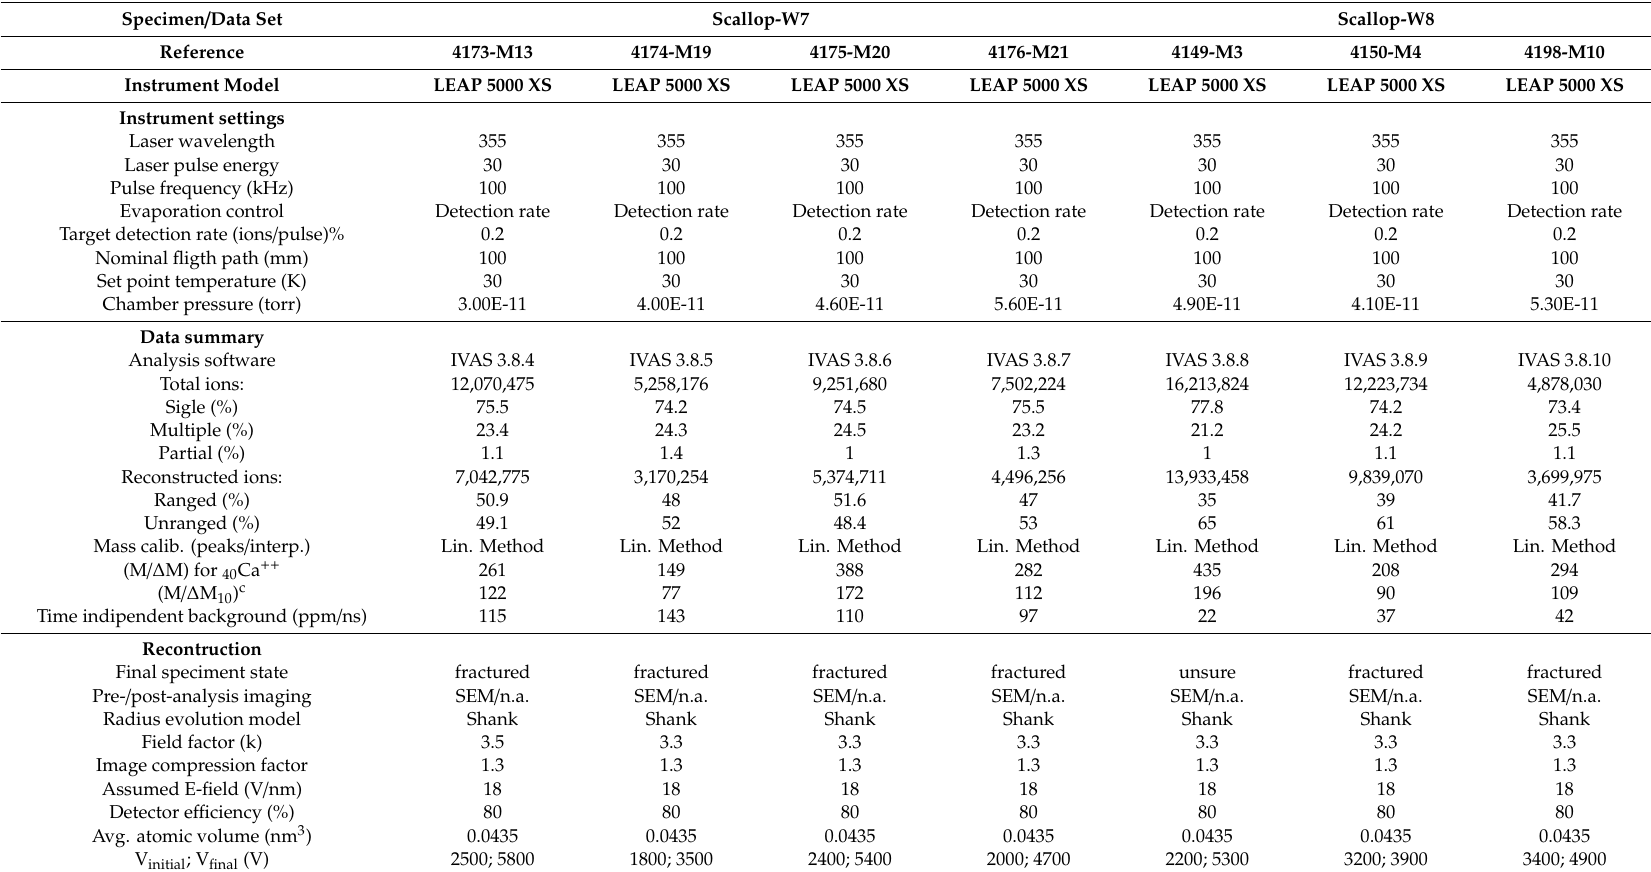
Table 1. Data acquisition settings for LEAP analyses and run